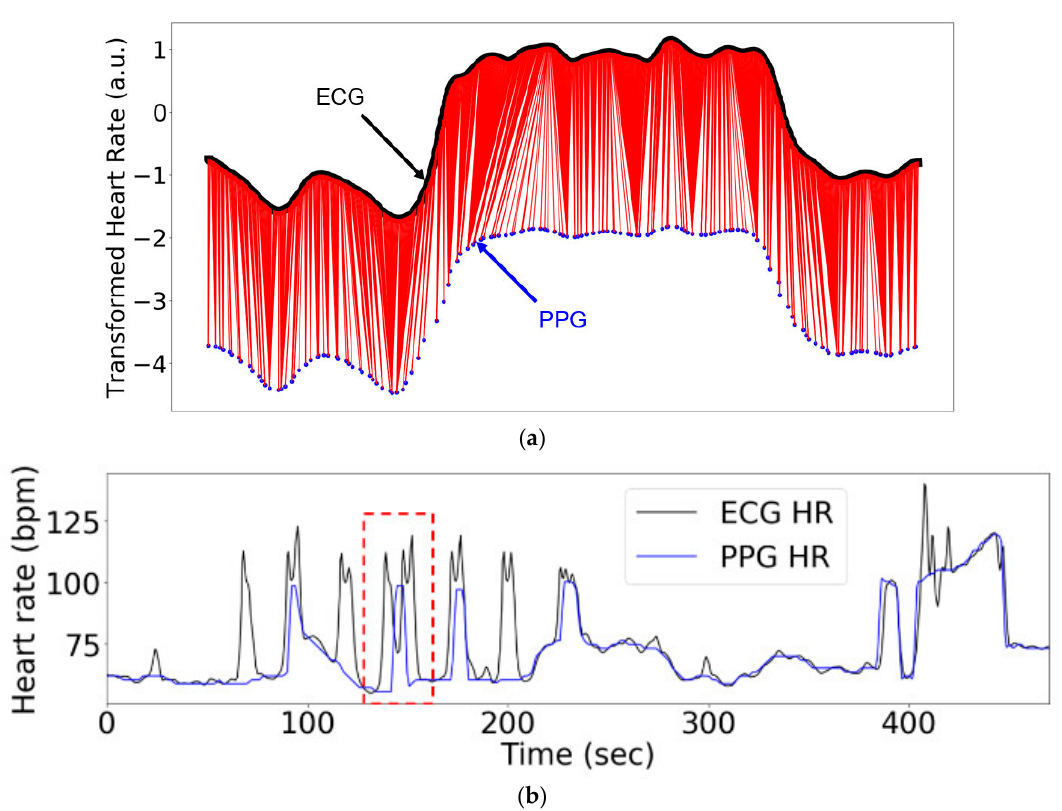
Figure 1. Real multi-modal biomedical signals underlie the need for both an improved alignment methodology and an improved metric to evaluate the resulting alignment: ( a ) Heart rate measured with ECG (black, ~1.26 Hz) and photoplethysmogram (PPG) (blue, ~0.2 Hz); ( b ) an example of warping and distortion observed when comparing the heart rates measured by ECG (black, ~1.26 Hz) and PPG (blue, ~0.2 Hz).